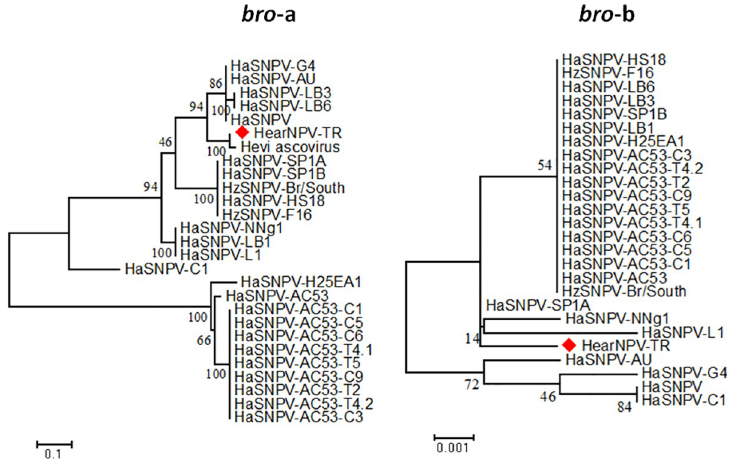
Fig 2. Phylogenetic analysis of bro s